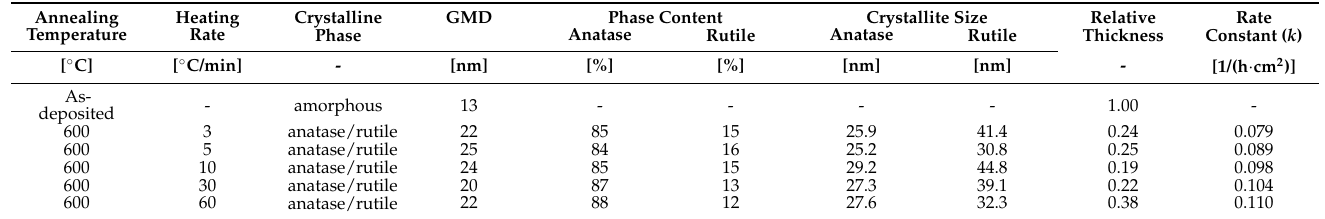
Table 1. Summary of Ag–TiO 2 nanocomposite films’ characterization and photocatalytic